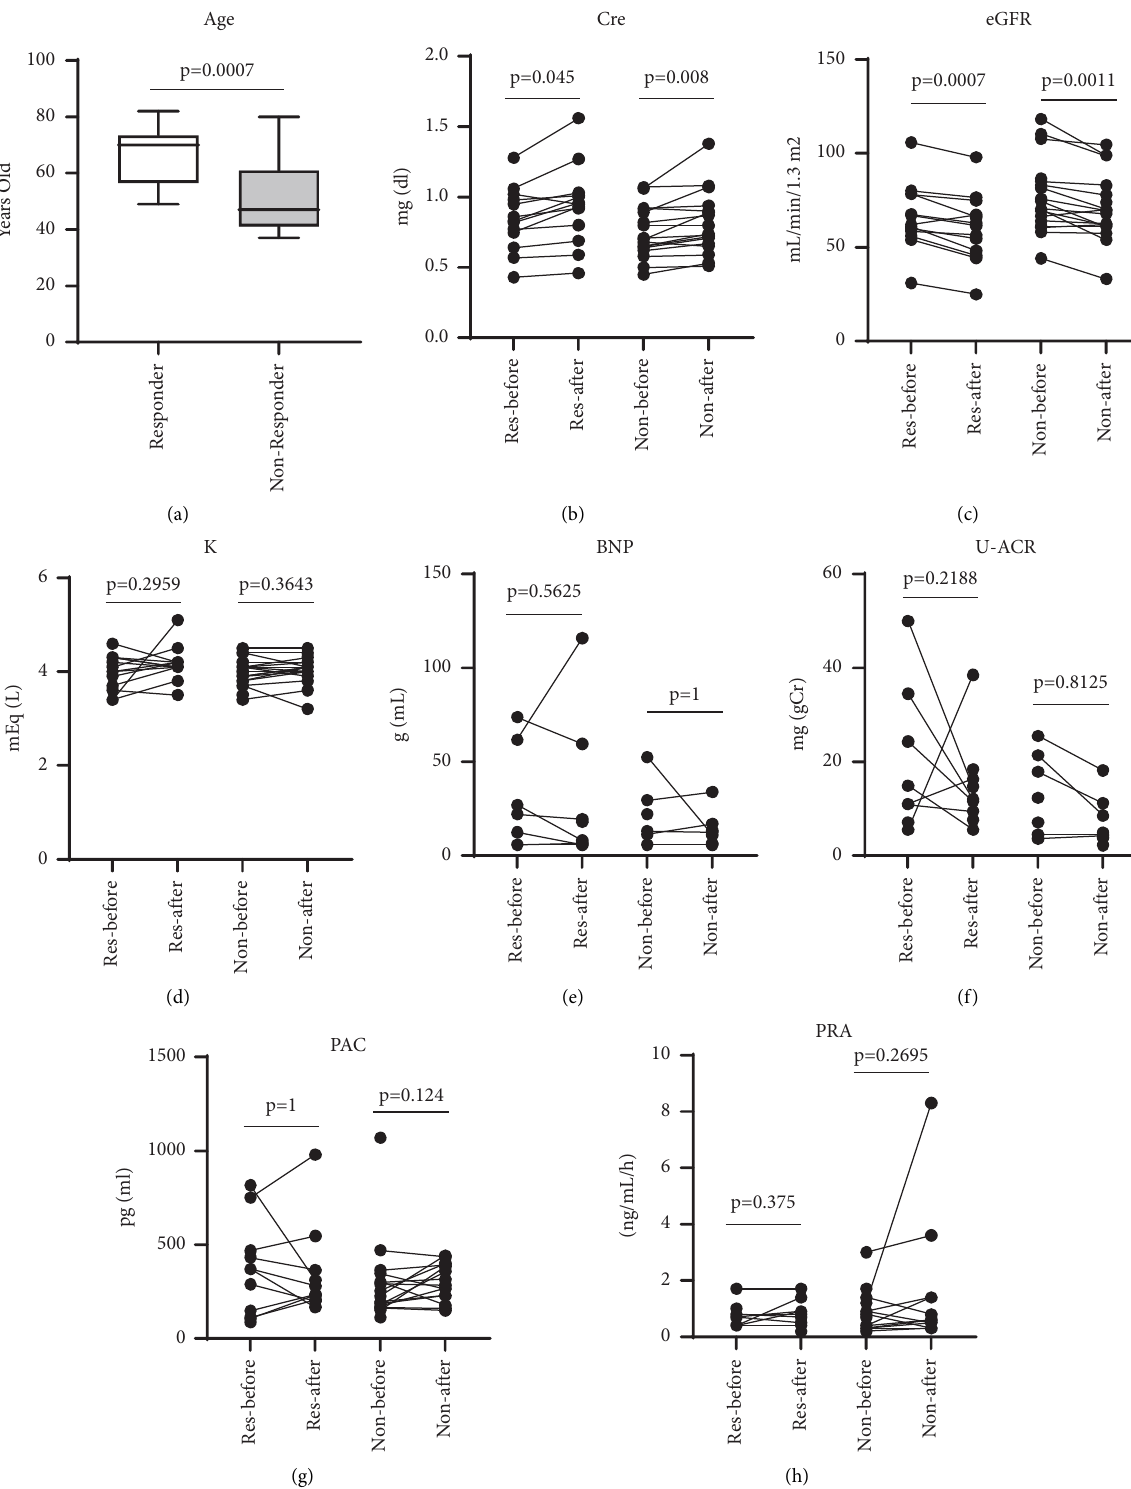
Figure 2: Comparison of clinical characteristics of 13 responders and 19 nonresponders. (a) Age. (b) Serum creatinine (Cre). (c) Estimated glomerular fltration rate (eGFR). (d) Serum potassium level (K). (e) Serum B-type natriuretic peptide (BNP) level. (f) Urine albumin- creatinine ratio (UACR). (g) Plasma aldosterone concentration (PAC). (h) Plasma renin activity (PRA). Bar graphs and error bars represent mean ±